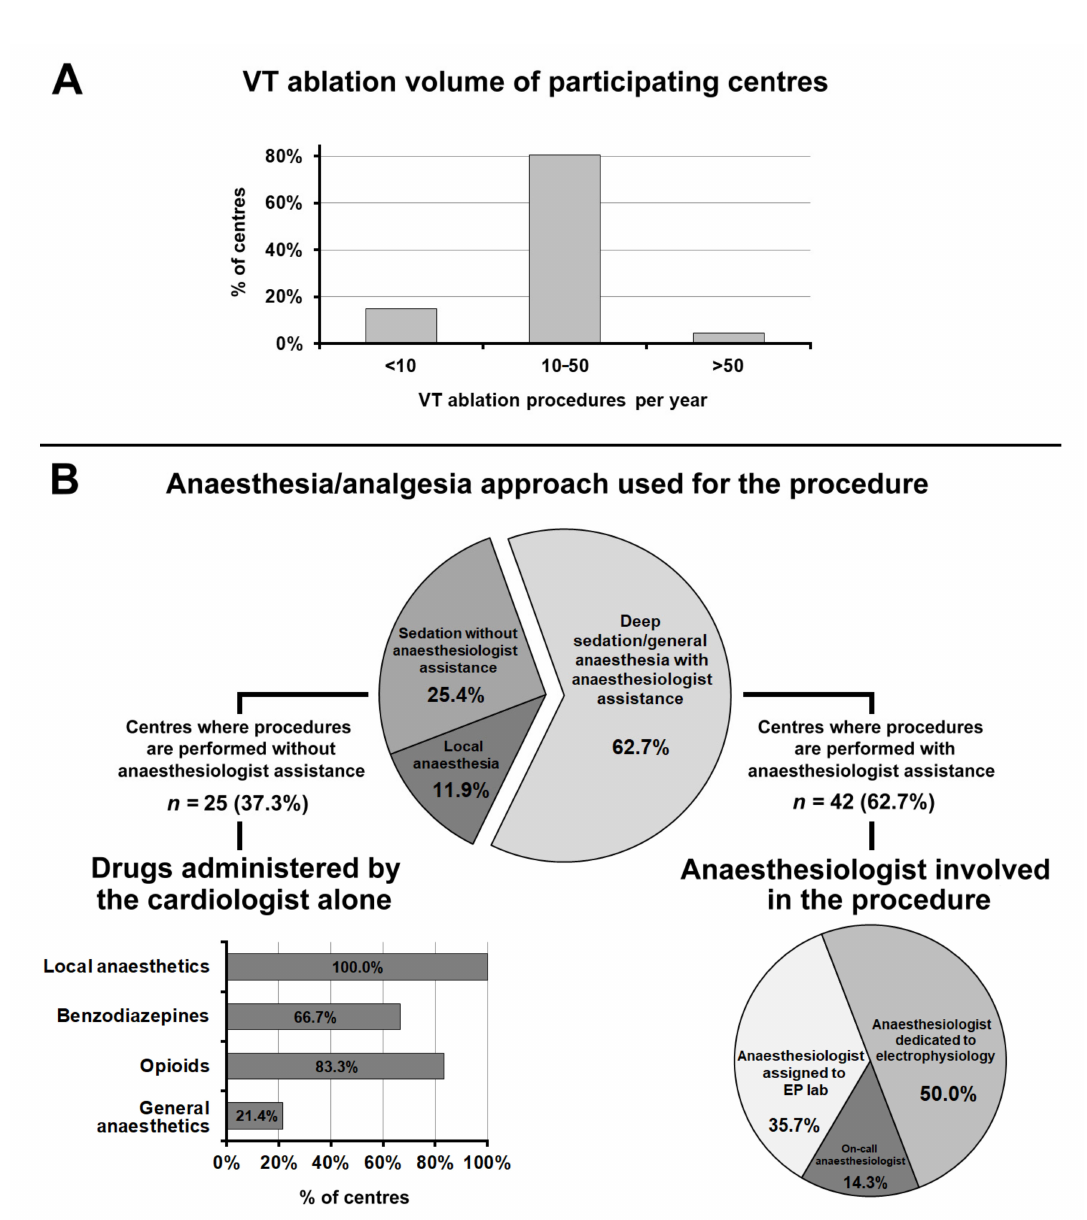
Figure 5. ( Panel A ): Ventricular tachycardia ablation procedure volumes of participating centres. ( Panel B ): Anaesthe- sia/analgesia approach used for the procedure. Abbreviations used in the figure. VT: ventricular tachycardia; EP lab: electrophysiology